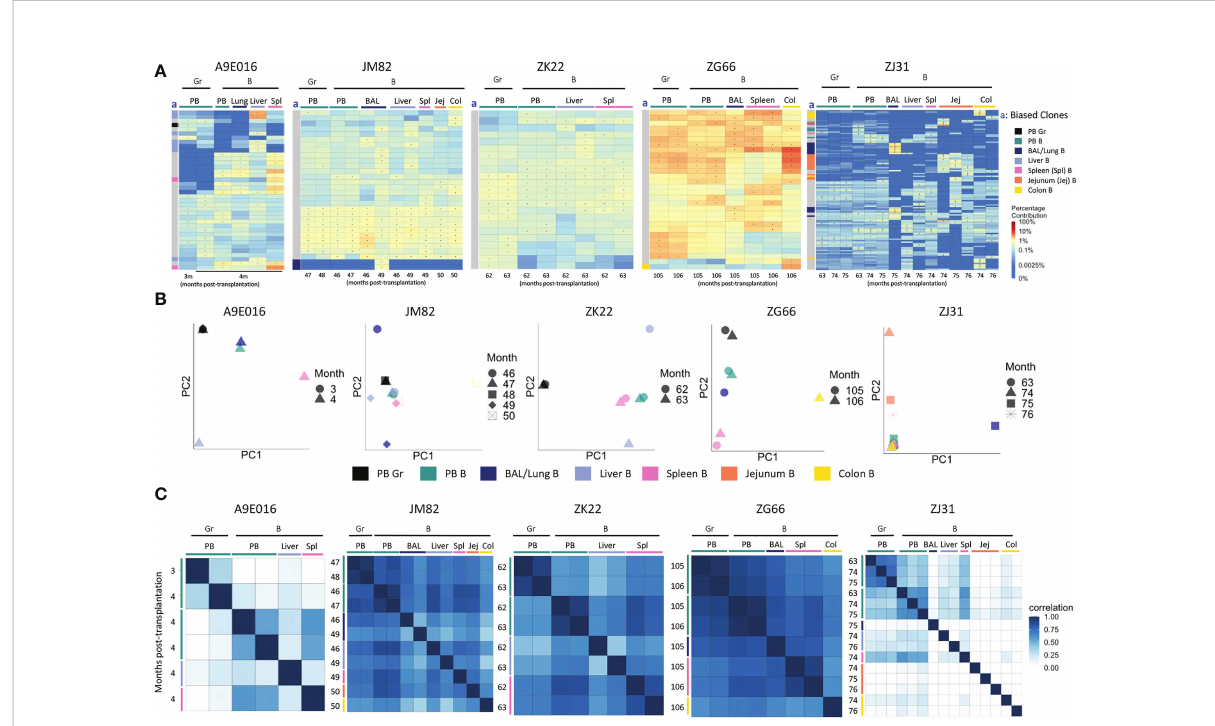
FIGURE 3 B cell and myeloid cell clonality analyses in blood and tissues (A) Heat maps of the natural log fractional abundance of the highest contributing clones de fi ned as all barcodes present as a top 10 highest contributing barcode in at least one of the PB granulocyte (Gr), PB B cell or tissue B cell samples puri fi ed from tissues at the designated time points, mapped over all samples for each animal (A9E016, JM82, ZK22, ZJ31 and ZG66). Heatmaps were constructed as in Figure 2A. The column labeled “ a ” on the far left of each heatmap designate tissue-speci fi c “ biased ” barcoded clones, de fi ned as > 5x expanded in a speci fi c tissue ’ s B cells compared to B cells from all other tissues or Gr from blood, ie clones that are expanded in one speci fi c tissue compared to all other locations. For samples with multiple timepoints, the average clonal contribution across timepoints was used. Color coding for each speci fi c set of biased clones is shown to the far right. Jej-jejunum; Spl-spleen; Col-Colon. (B) PCA analysis of the Gr and B cell clones from PB and B cell clones from tissues. The samples collected from different anatomical locations are represented with different colors (color legend located below the PCA plots), and samples from the same location collected at different time points post-transplantation are denoted using different markers. PCA projections are performed as detailed in Figure 2B. (C) Pairwise Pearson correlation coef fi cients heatmaps showing the pairwise clonal correlations of contributions from all barcodes retrieved from PB Gr and B cells and from tissue B cells collected at the designated time points post-transplantation. The color scale for r values is shown on the right of the panels. Jej, jejunum; Spl, spleen; Col, Colon. * in the barcode heatmap indicates the barcode is one of the top 10 for that